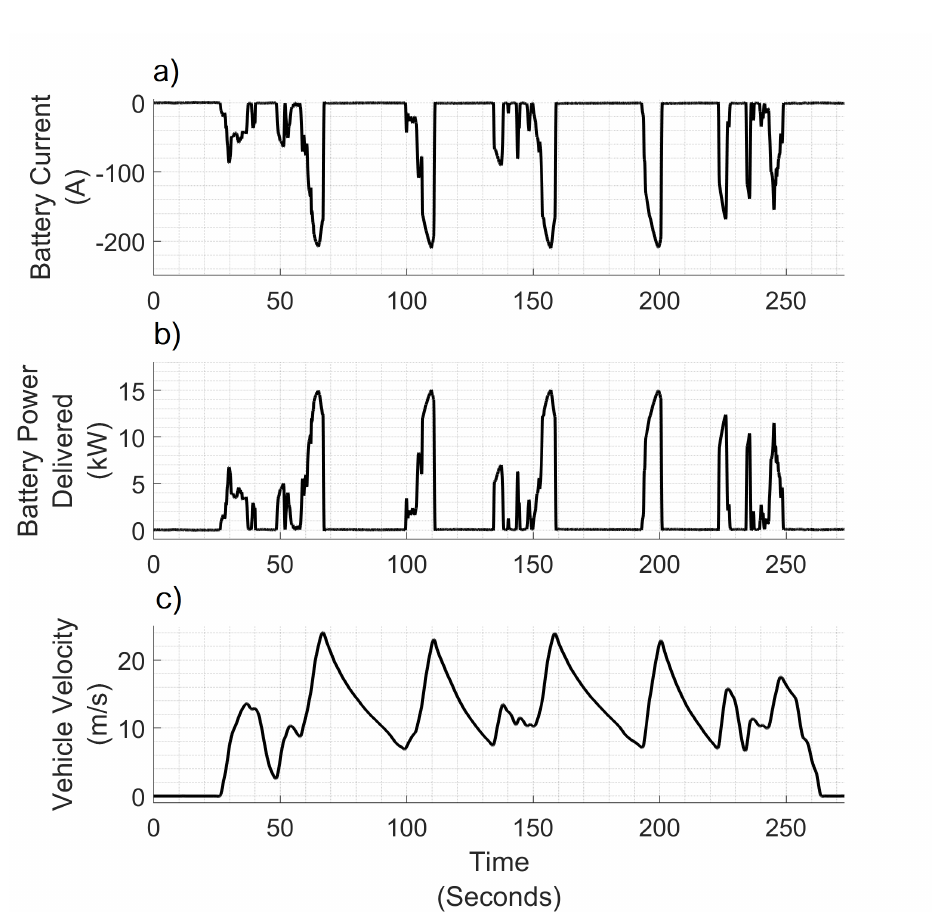
Figure 10. Test #3.1: ( a ) current and ( b ) power (kW) delivered from the battery and ( c ) vehicle velocity profile during a Coastdown test session composed by several acceleration and deceleration